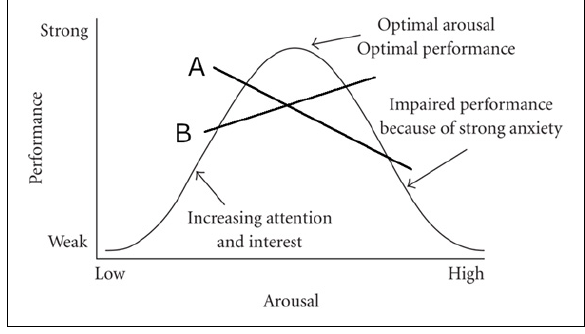
Figure 2: The Yerkes-Dodson Curve. The lines A and B show how it is possible to find negative and positive (but misleading) effects of stress on performance. The Yerkes-Dodson curve could be simply quadratic, or taper off at the end to look more Gaussian, or be asymmetrical and piecewise and only roughly approximate a quadratic